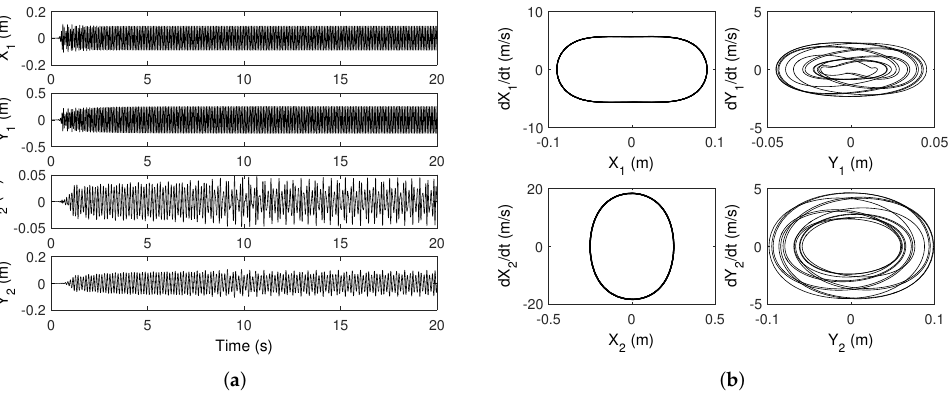
Figure 4. Nonlinear transient and steady-state self-excited friction-induced vibrations for µ = 0.7. ( a ) Displacements. ( b ) Limit